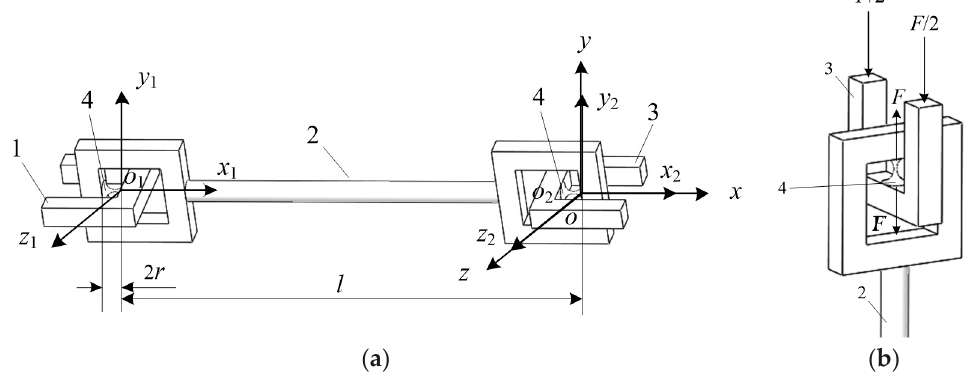
Figure 4. A novel serial RCCS flexural joint chain structure based on an RCCS flexural joint: ( a ) a serial chain of two compliant spherical joints with the force-inverted structure; ( b ) compliant spherical joint force-inverted structure.